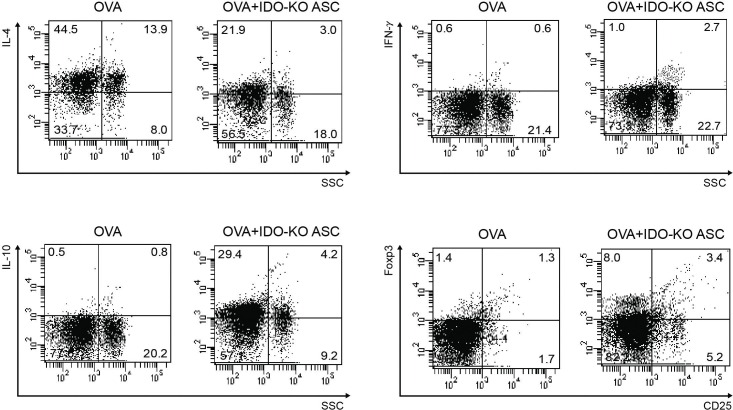
Effects of adipose-derived stem cells (ASCs) on T-cells in the lung draining lymph nodes.The CD4+ T-cells were initially gated and the percentage of IL-4+, IFN-γ+, IL-10+, and CD25+ Foxp3+ T-cells subsequently analyzed. When treating asthmatic mice with ASCs derived from indoleamine 2, 3-dioxygenase (IDO)-knockout (KO) mice, the IL-4+ T-cell population decreased, but the IFN-γ+, IL-10+, and Foxp3+CD25+ T-cell populations increased.